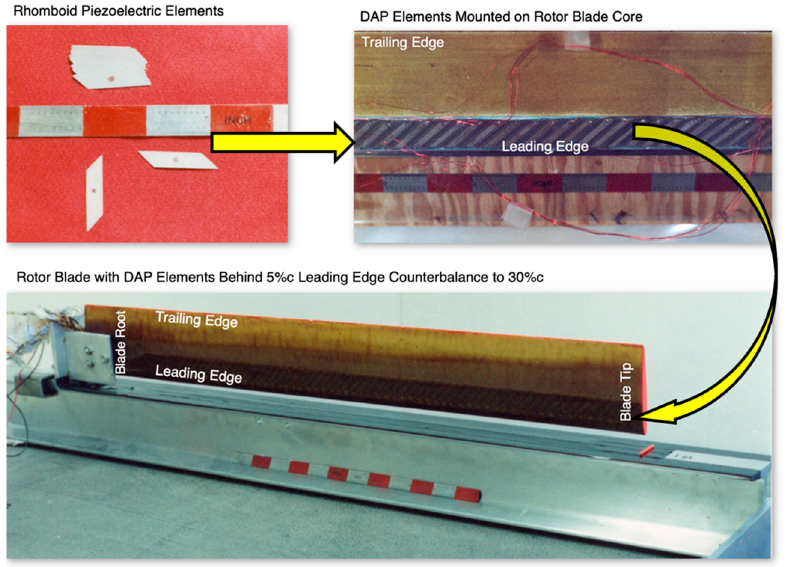
Figure 2. DAP elements and DAP rotor blade during fabrication and on the test stand [10].